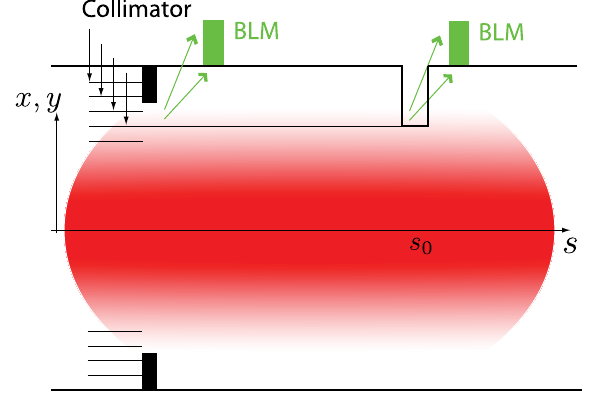
FIG. 1. Collimator scan with transverse damper beam blowup technique illustration. The reference collimator is indicated in black and the BLMs in green. Note that in this example, five collimator steps were performed spaced about a given fraction of σ . Reprinted under CC BY 4.0 license from paper